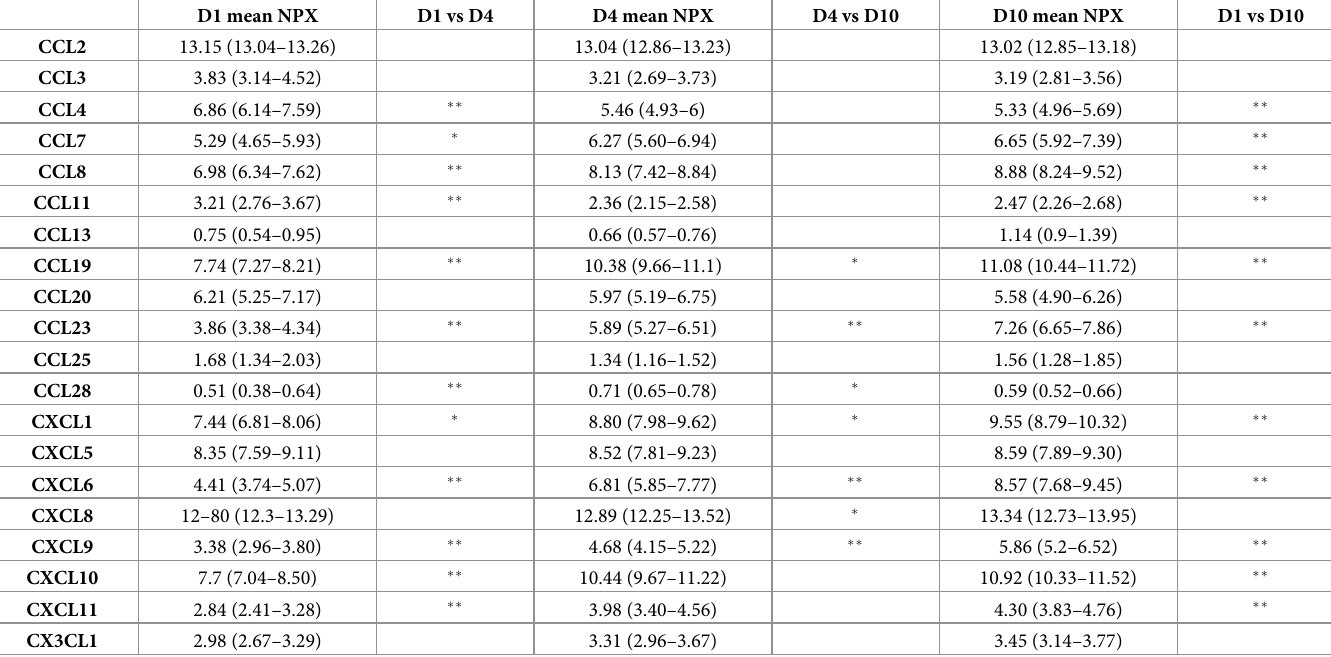
Table 1. Between-days comparisons of mean NPX values (+/- 0.95 CI) for each chemokine. D1 mean NPX